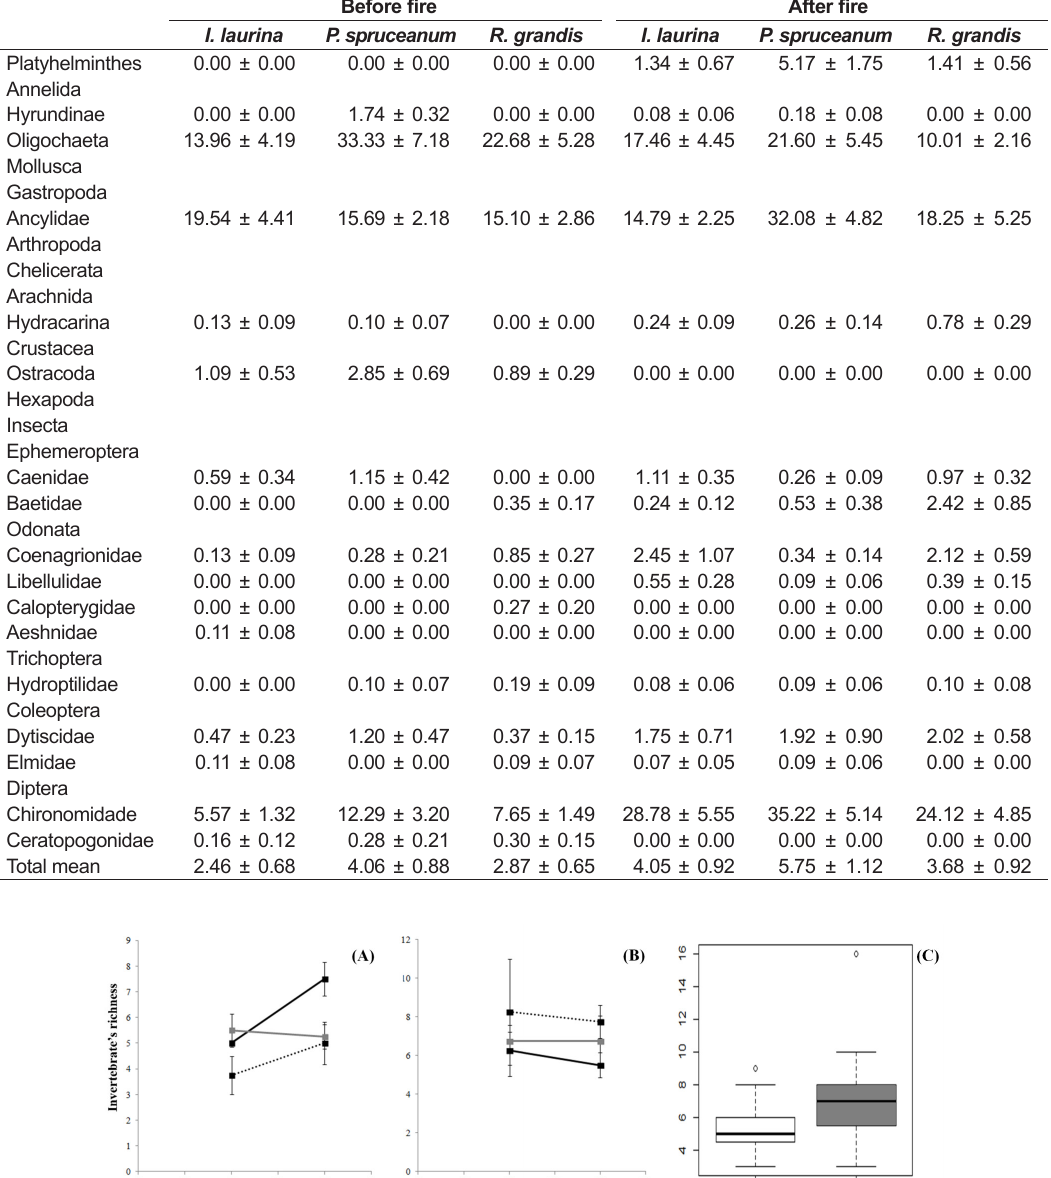
Table 2. Mean (ind.g -1 ) and standard error (±) for invertebrates in litter of I. laurina, P. spruceanum and R. grandis before and after fire in a tropical stream